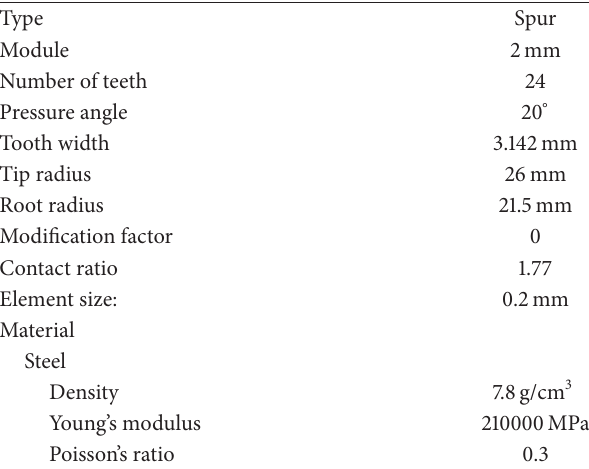
Table 1: Gear model parameters.